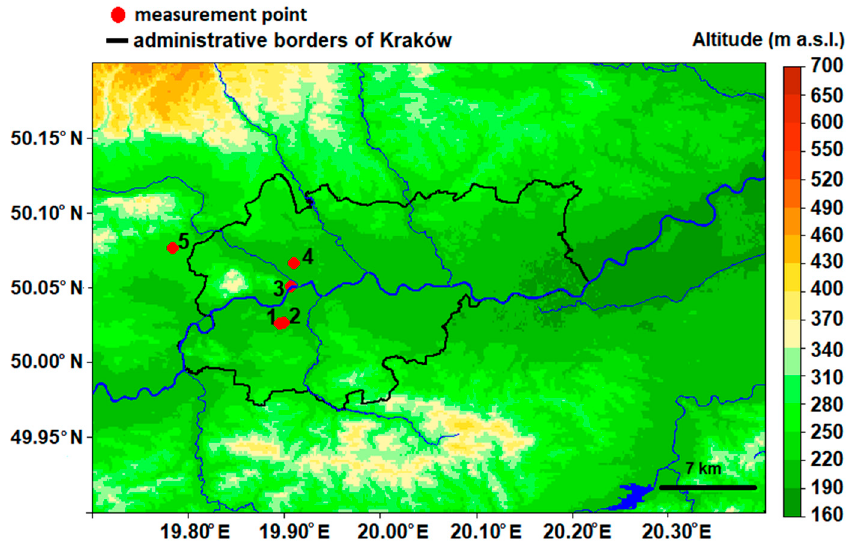
Figure 7. Location of measurement points in Krakow.